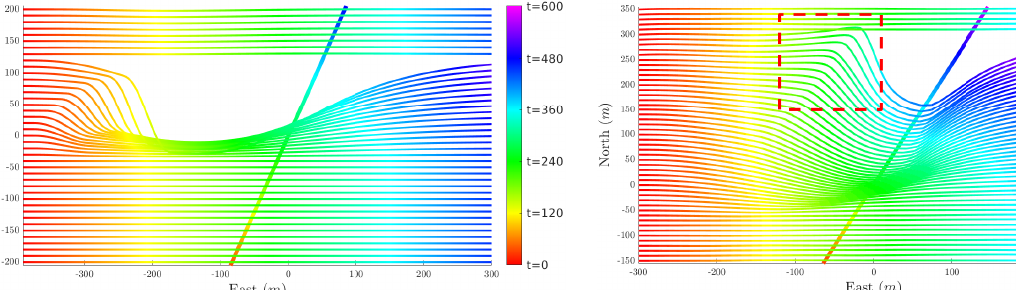
Figure 14: Comparison of give-way encounters.